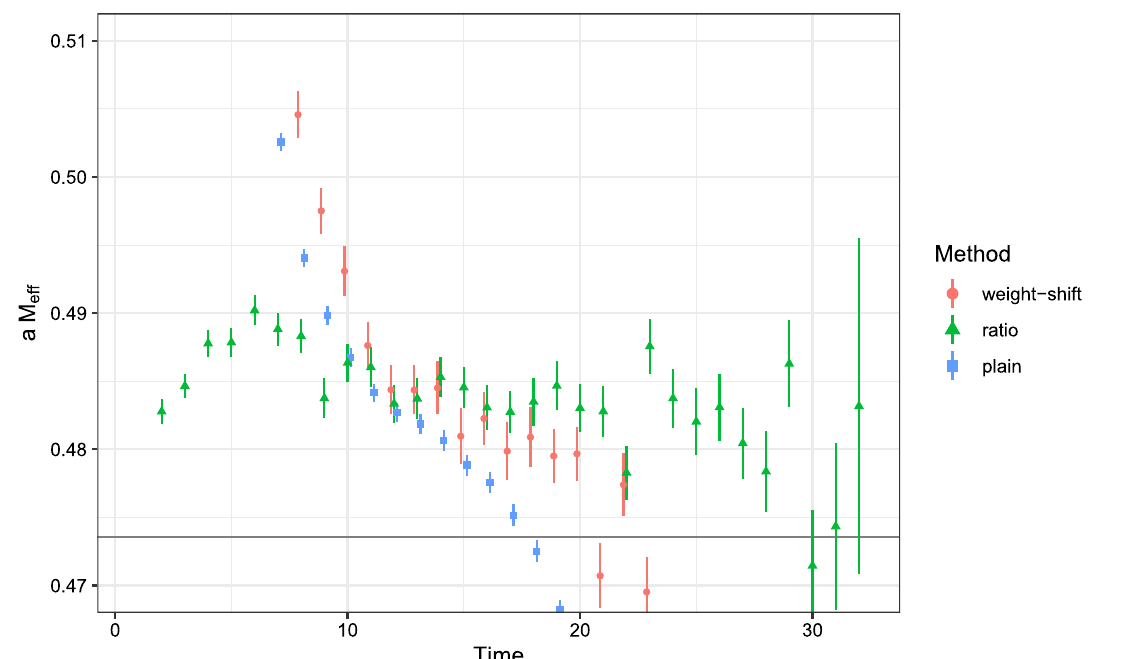
Fig. 7 Effective mass for the three-pion ground state ( A − the cA2.60.32 ensemble. Shown are in blue the plain correlator without any thermal state treatment, in red the correlator treated with weight-